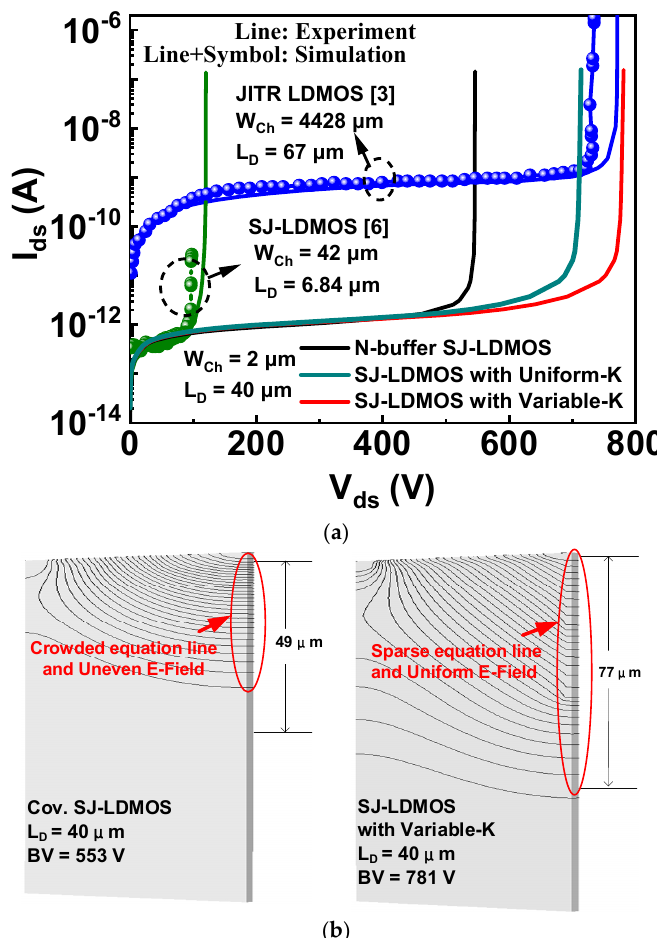
Figure 3. ( a ) Experimental and simulation breakdown characteristics for the conventional buffered SJ-LDMOS, VHK SJ-LDMOS, and Triple RESURF LDMOS. The experimental data were extracted from the experimental Ids-Vds curves in N-Buffer SJ-LDMOS and JITR LDMOS. ( b ) Equipo- tential contour plots of conventical SJ-LDMOS and VHK SJ-LDMOS (W N = W P = 1.0 µ